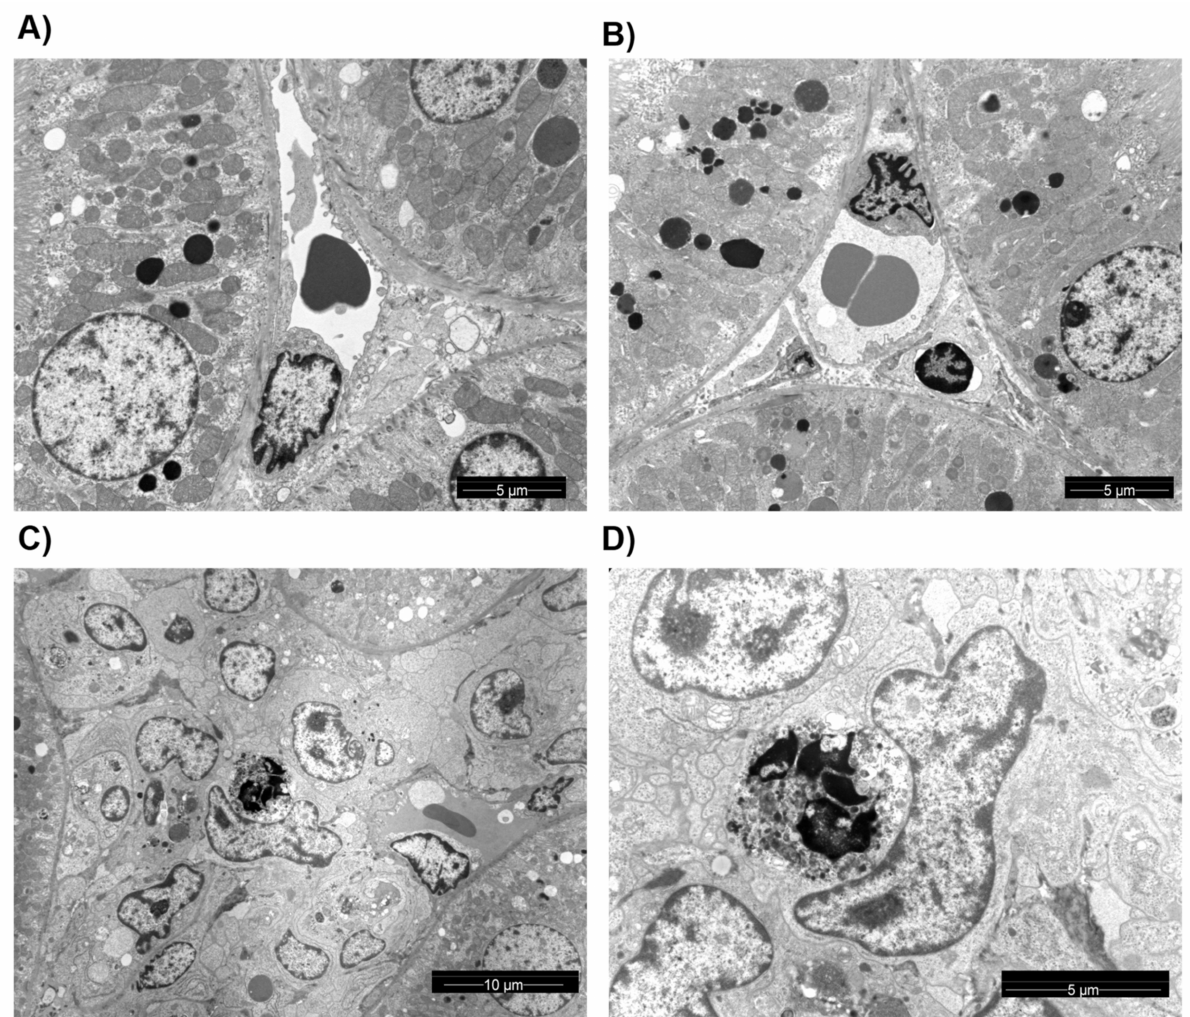
Figure 7. Ultra-structural analysis. Kidney section from CTR ( A ), sTX ( B ), and aTX ( C , D ) transplanted kidneys were used for ultrastructural analysis. The control and syngeneic transplanted kidneys showed normal morphology. Allogeneic transplanted kidneys with TCMR showed apoptosis and activation of Mphi (marked by a white arrow) engulfing apoptotic debris (marked by the black